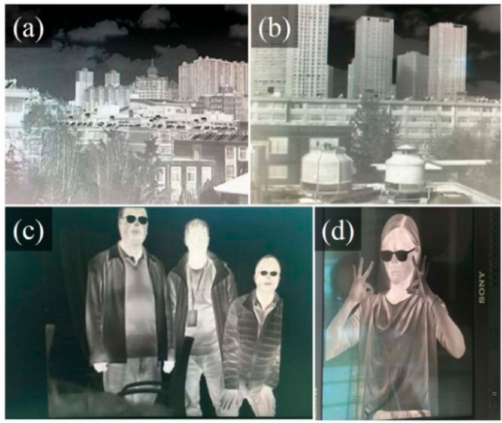
Figure 12. Images of the freeform IR un-cooled thermal imager at different distances: ( a ) 2000 m, ( b ) 500 m, ( c ) 50 m, and ( d ) 10